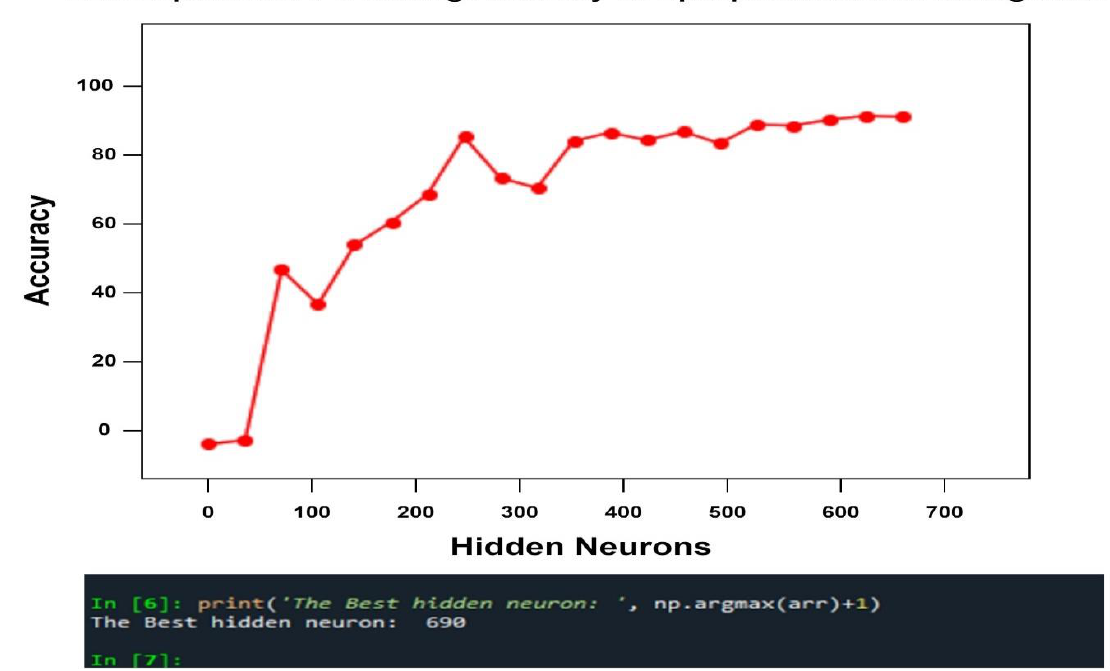
Figure 7. ELM Model Accuracy of Experiment #3.